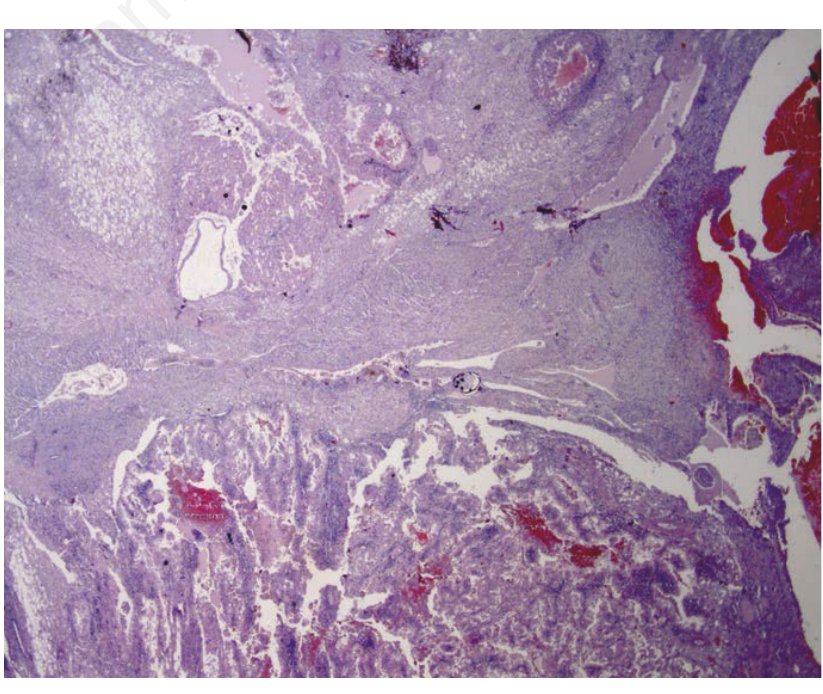
Figure 2. Histological aspect of the right kidney (Hematoxylin-eosin, original magnifica- tion X125): renal cell carcinoma on the bottom; solid portion of the angiomyolipoma at the top, its cystic portion on the